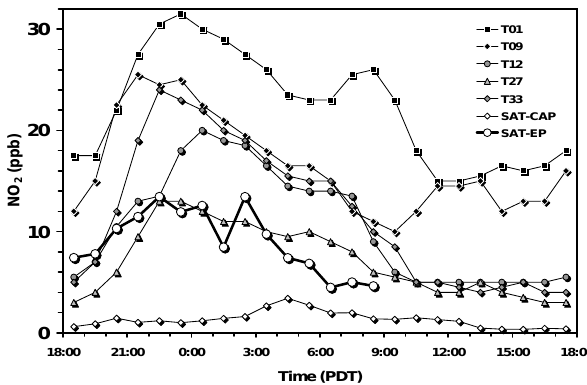
Fig. 5. Comparison of NO 2 diurnal profiles at Saturna Island, East Point (SAT-EP) versus the Saturna CAPMon station (SAT-CAP) and other LFV monitoring stations (refer to Fig. 1). Hourly aver- age mixing ratios are shown. Statistical ranges are not shown for